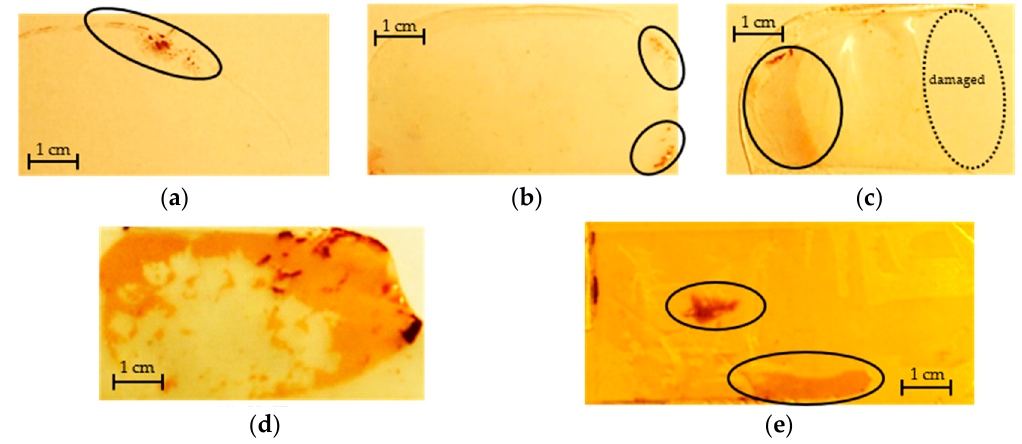
Figure 2. Residuals on the different molds after demolding. In the above figures, except for Figure 2d, the residuals are all circled. In Figure 2c, the dash circle represents the area that is damaged in demolding. ( a ) Glass; ( b ) PLA; ( c ) SEBS; ( d ) SMP; ( e )